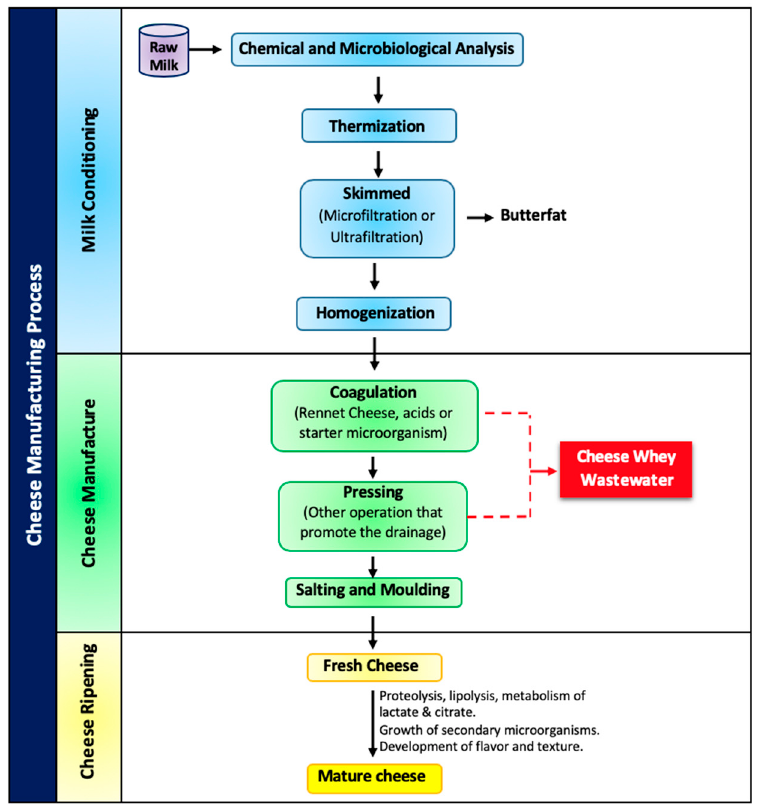
Figure 1. General diagram of the cheese manufacturing process.